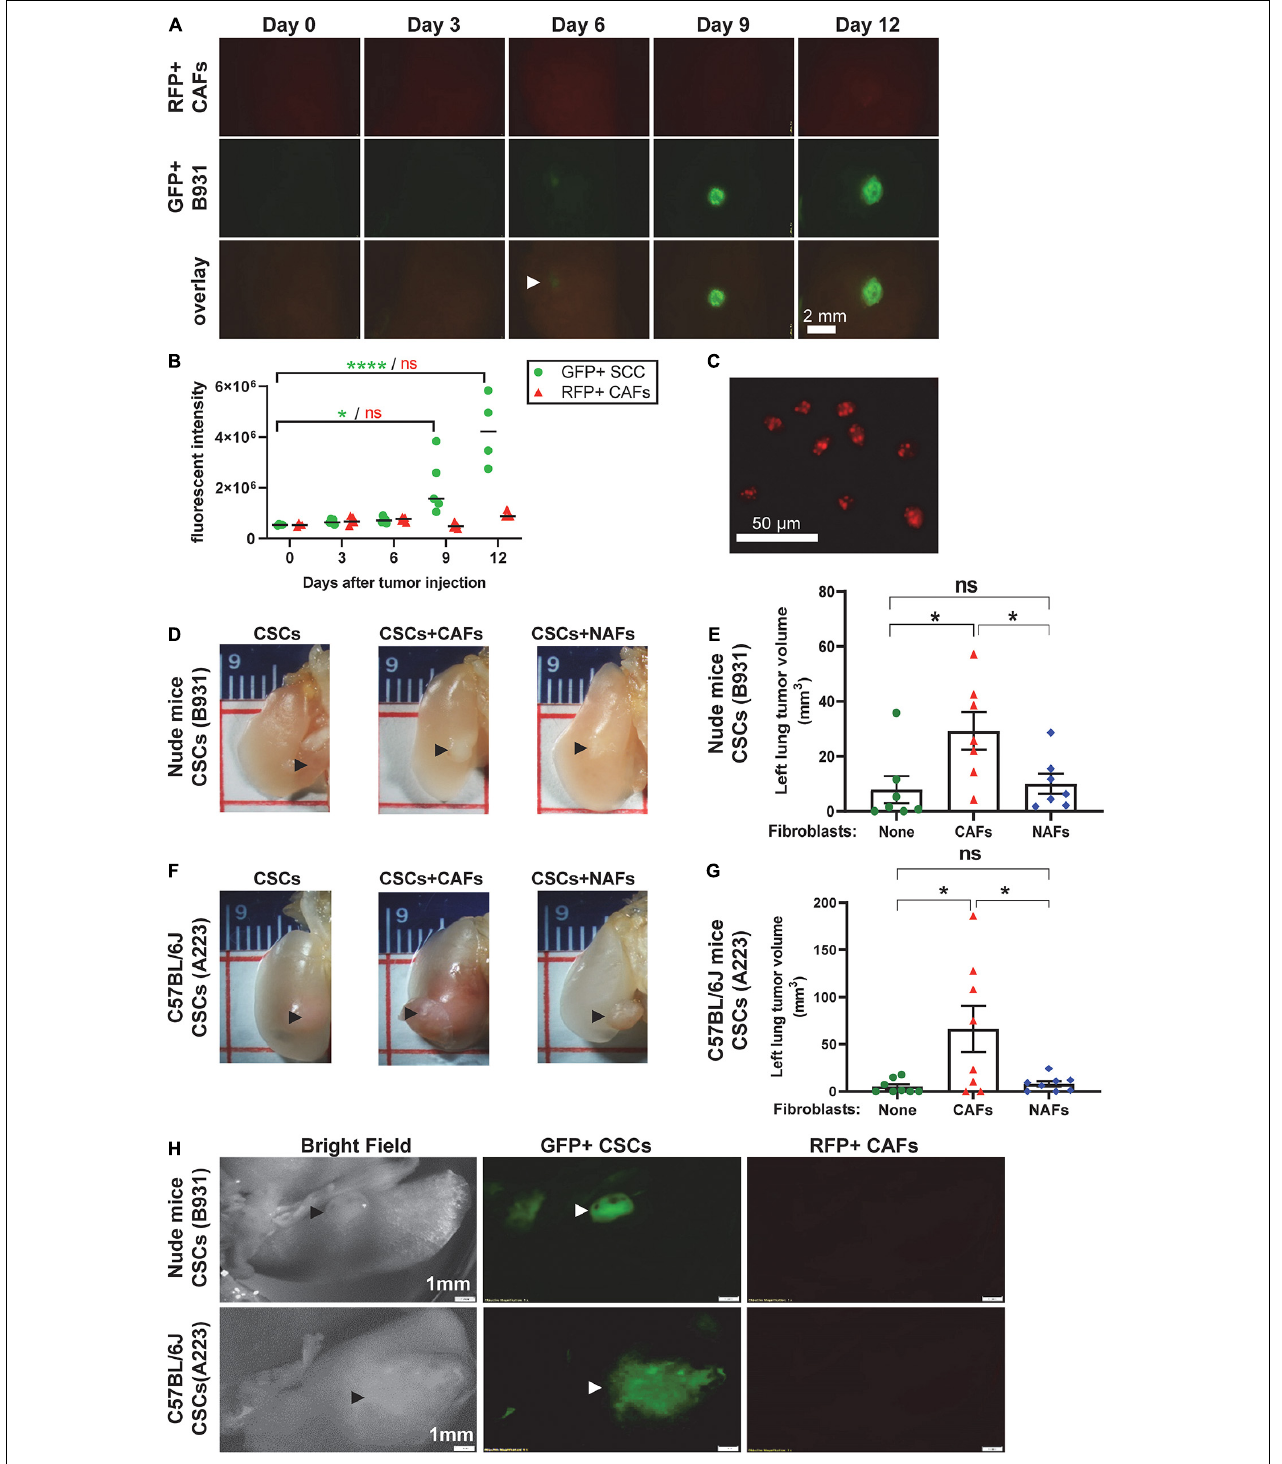
FIGURE 4 | Cancer-associated fibroblasts did not expand with CSC cells but facilitated CSC cell seeding and expansion in the left lung. Transplanted A223 and B931 CSCs were used in all experiments as indicated. (A,B) 10,000 GFP + B931 cells were co-transplanted with 50,000 RFP + CAFs directly to the left lung and 4–5 mice were sacrificed on days 0, 3, 6, 9, and 12 post-transplant and left lungs imaged as described in panel (F) to detect GFP and RFP positive lesions. Representative images of lungs at each time point are presented in panel (A) and quantification of GFP and RFP intensity is presented in panel (B) . (C) RFP + CAFs were imaged with an inverted fluorescent microscope using a 10 × objective to demonstrate RFP positivity. (D–G) Representative images of left lung tumor, and